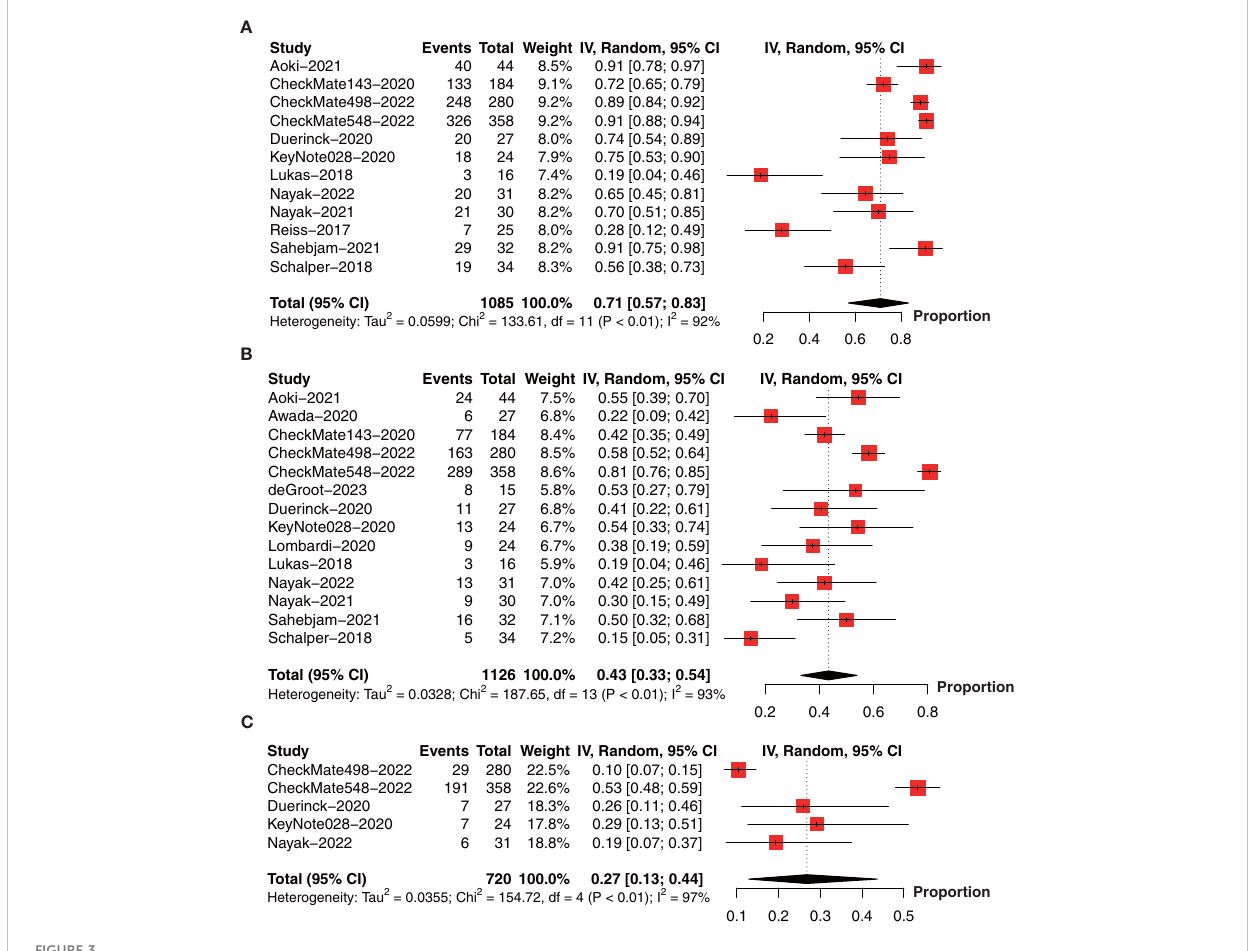
FIGURE 3 Forest plot showing the (A) 6-month, (B) 1-year, and (C) 2-year overall survival of glioma patients treated with PD-1/PD-L1